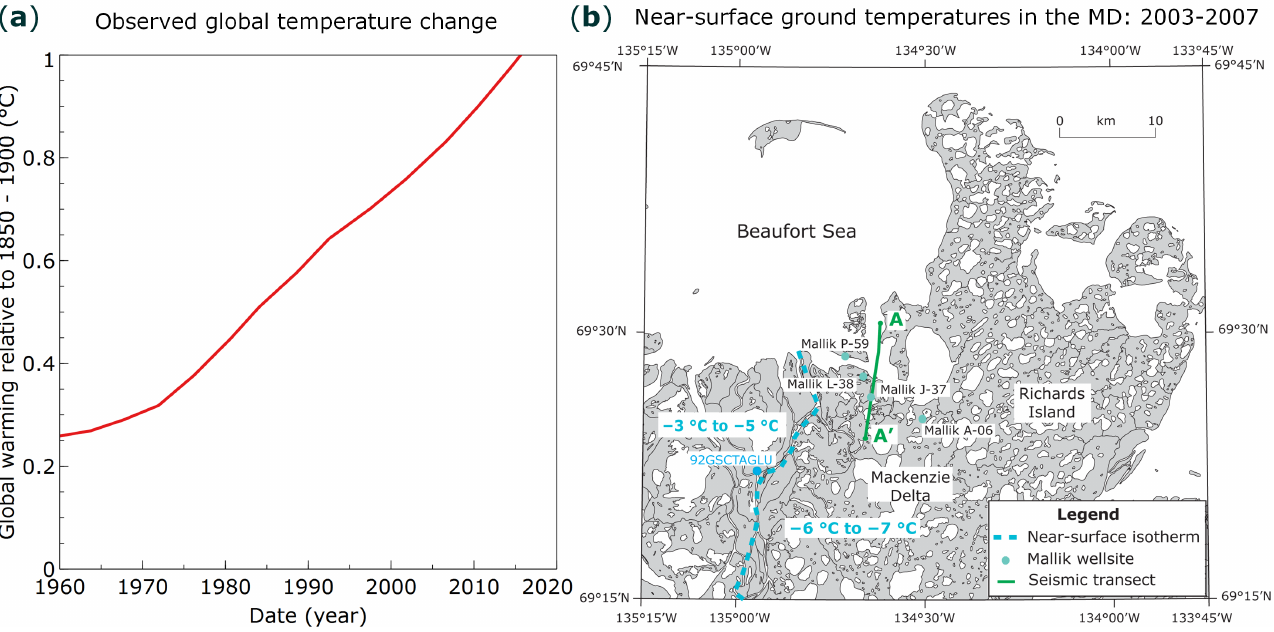
Figure 7. ( a ) Observed monthly global mean surface temperature change and estimated temperature increase due to global warming from 1960 to 2017 (adopted from IPCC estimates [82]); ( b ) map of the near-surface ground temperature distribution, measured between 2003 and 2007 in the Mackenzie Delta (temperatures adopted from Burn and Kokelj [92]). ( b ) presented with permission from Natural Resources Canada under the Open Government License—Canada version